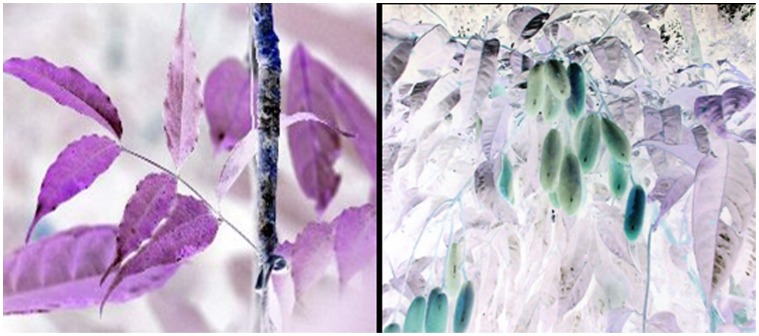
Photos of Fumbwa leaves (A) and Africanum pear Safou fruit (B).